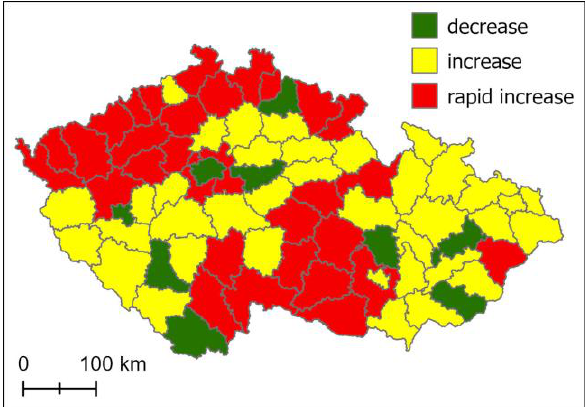
Figure 3. The trends in the number of forest fires in various districts of the Czech